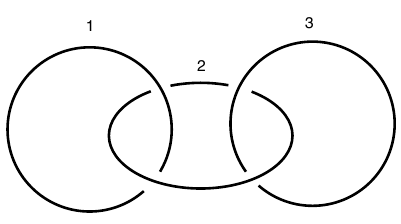
Figure 11 . A three component link which is the connected sum of two Hopf